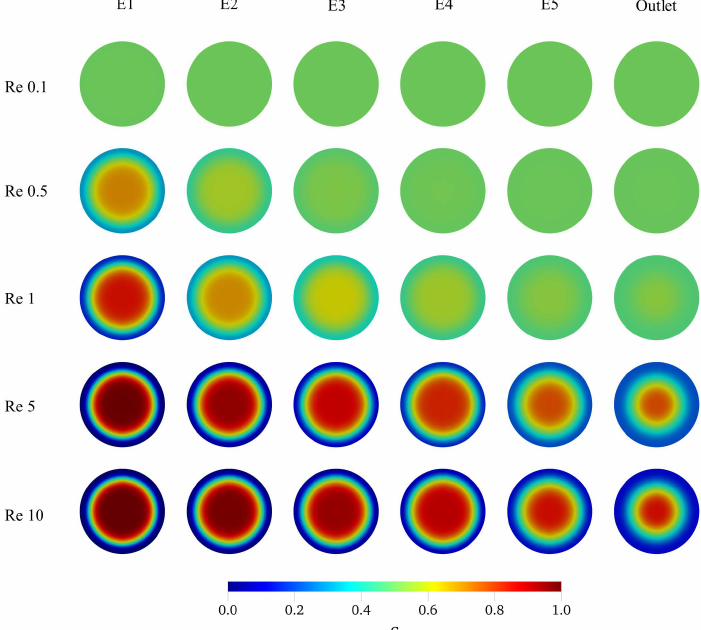
Figure A6. The development of fluid mixing along the CSFO–A micromixer configuration for all flow scenarios of D 1 diffusion constant. Circular planes show the distribution of scalar concentration on the exit cross-section of mixing units (E1, E2, E3, E4, and E5) and outlet of the CSFO micromixer. E1, E2, E3, E4, E5, and outlet planes are normal to the